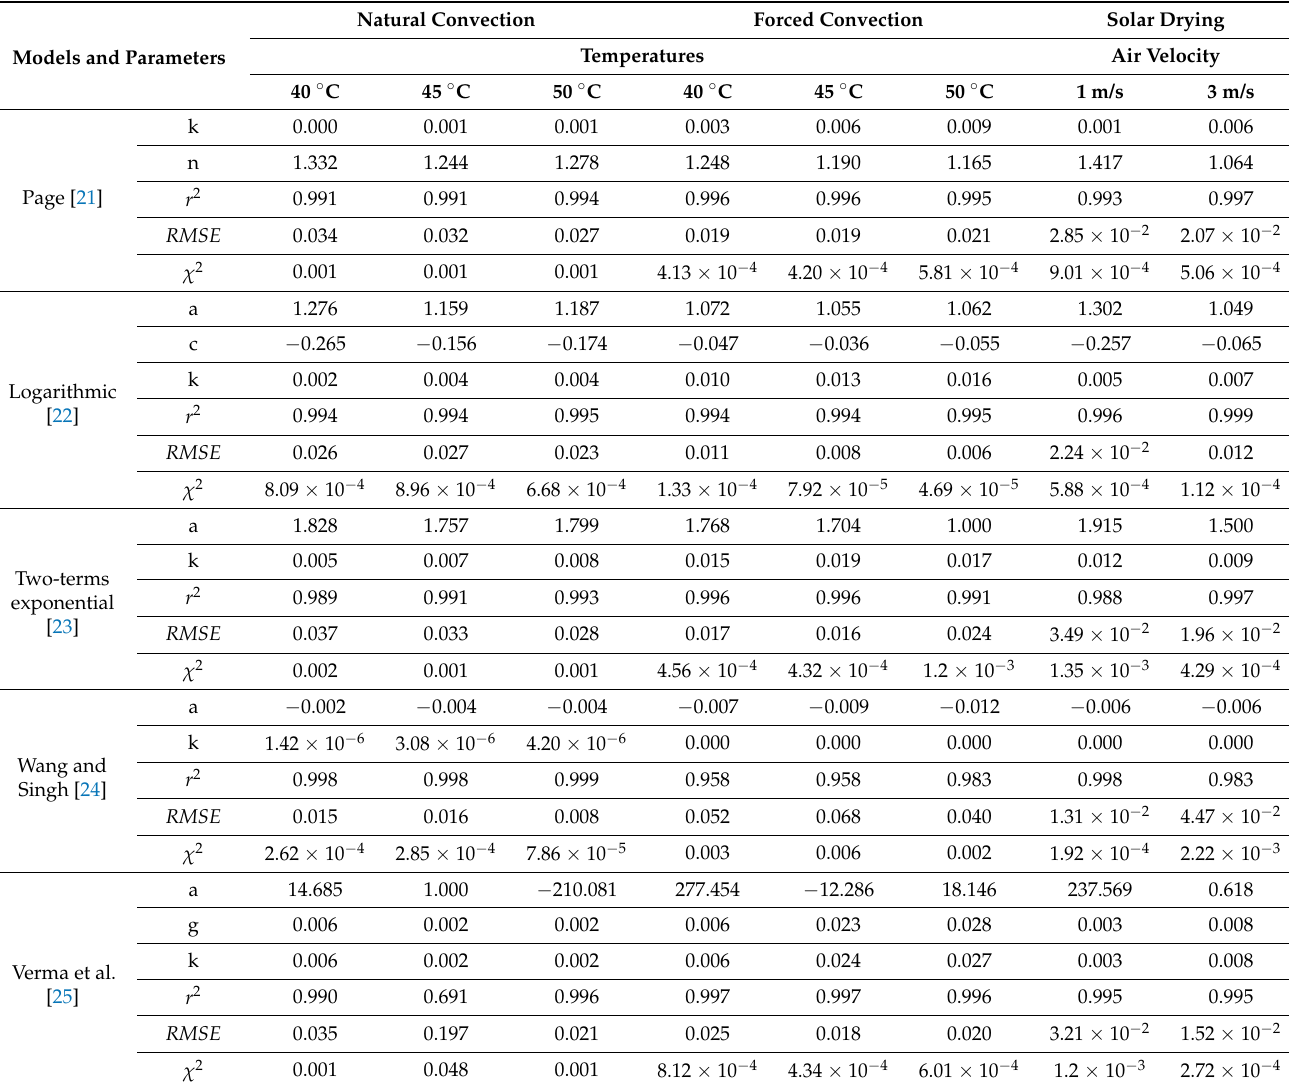
Table 2. Statistical results and fitting models at different drying temperatures (natural and forced